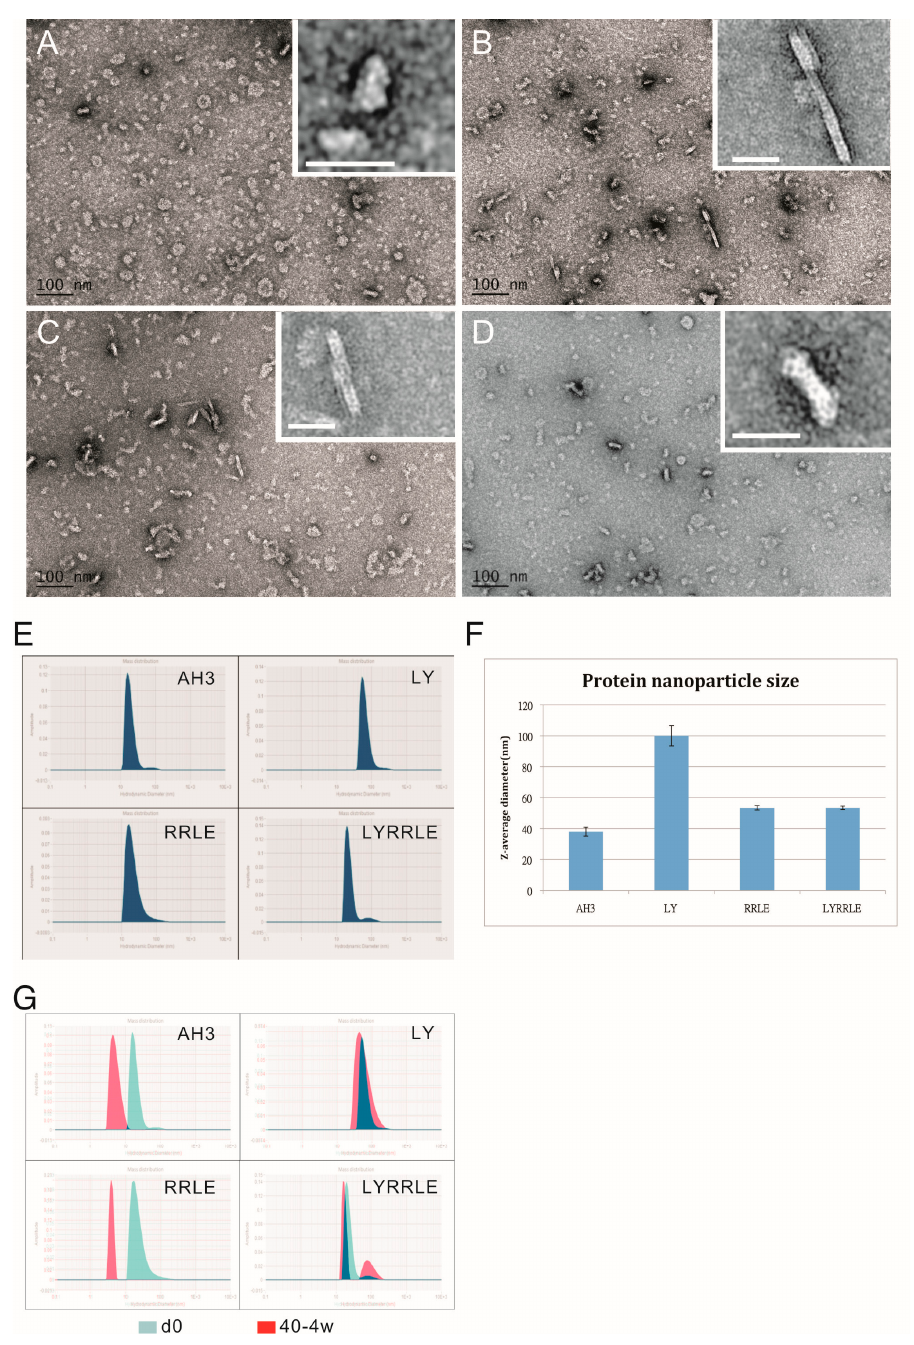
The combined line plot data showed the fluorescent intensity along the centrifuge tube from top to bottom. The image pixels had been averaged by the “smooth” command of imageJ before line plot analysis.